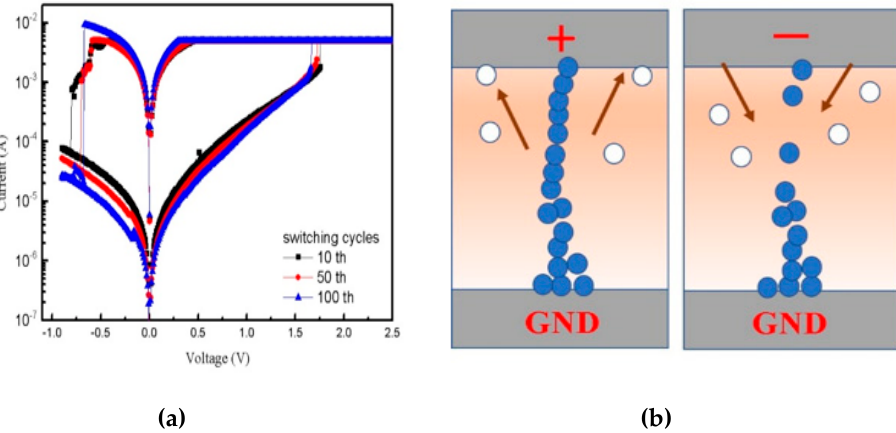
Figure 3. ( a ) IV sweep curve of IGO RRAM with TE of Pt. ( b ) The schematic of the redox mechanism with Pt TE. The blue circles present the oxygen vacancies and the white circles present the oxygen ions.